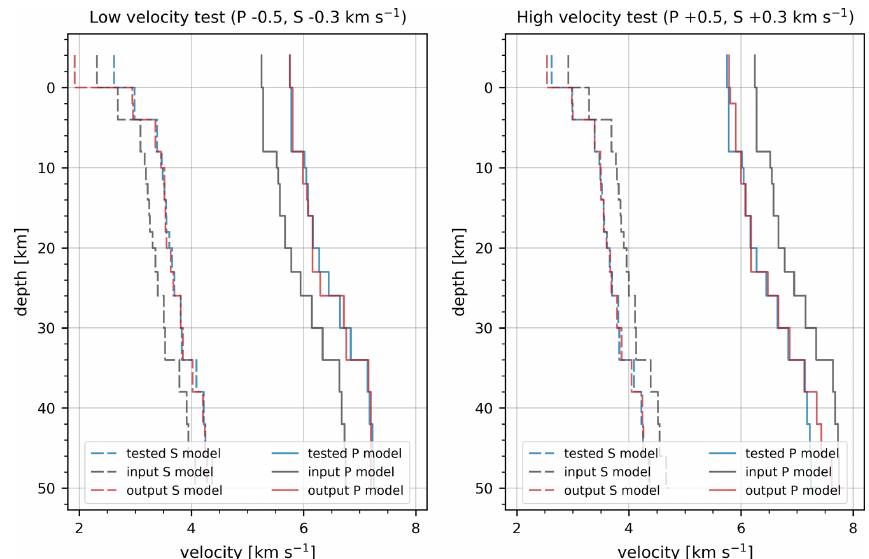
Figure 8. High-/low-velocity test for the MPS velocity model (blue), where we varied the P and S velocities by ± 0 . 5 and ± 0 . 3kms − 1 , respectively, and used them as the input velocity model (grey) for another inversion run with nine iterations. The output of this test is shown in